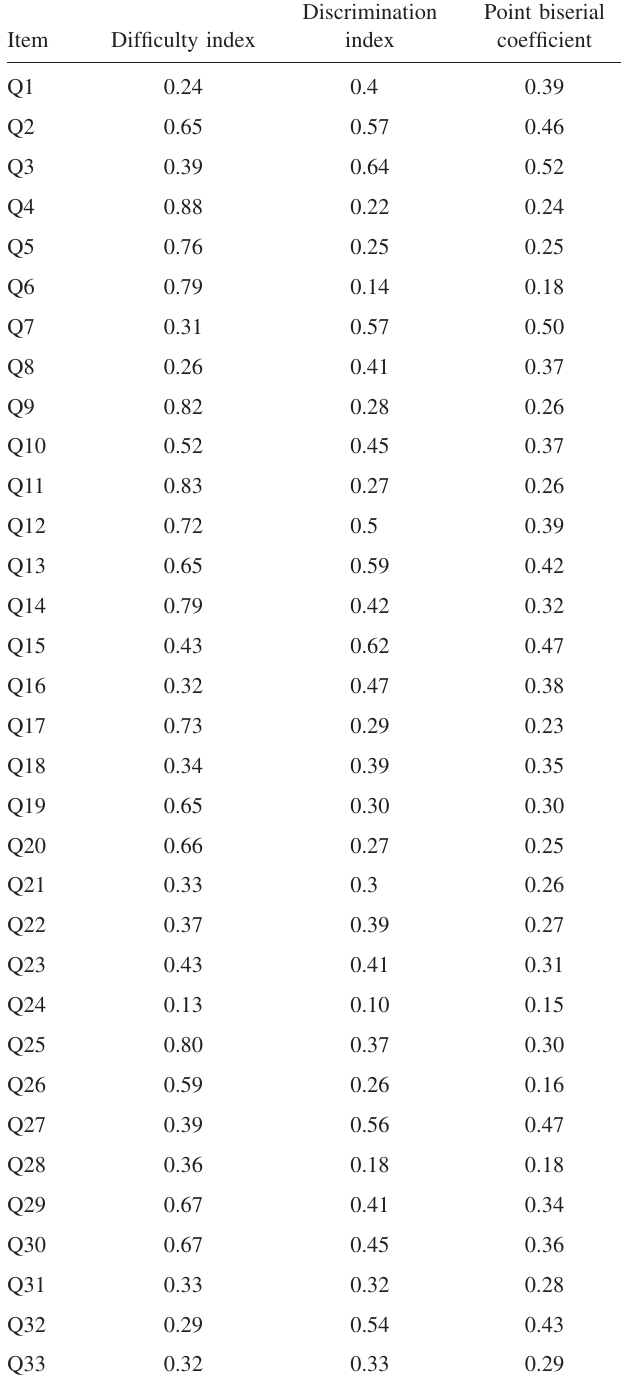
Carolina State University and Purdue University. The average total score is 17.4 out of 33 and the standard deviation is